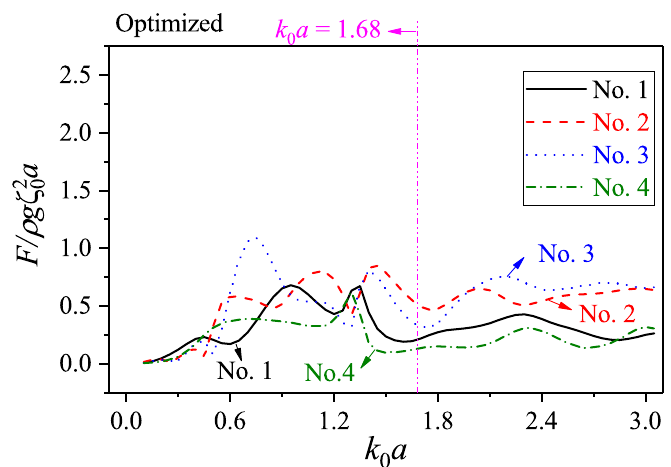
Figure 18. The wave drift forces on each cylinder with optimized structure.